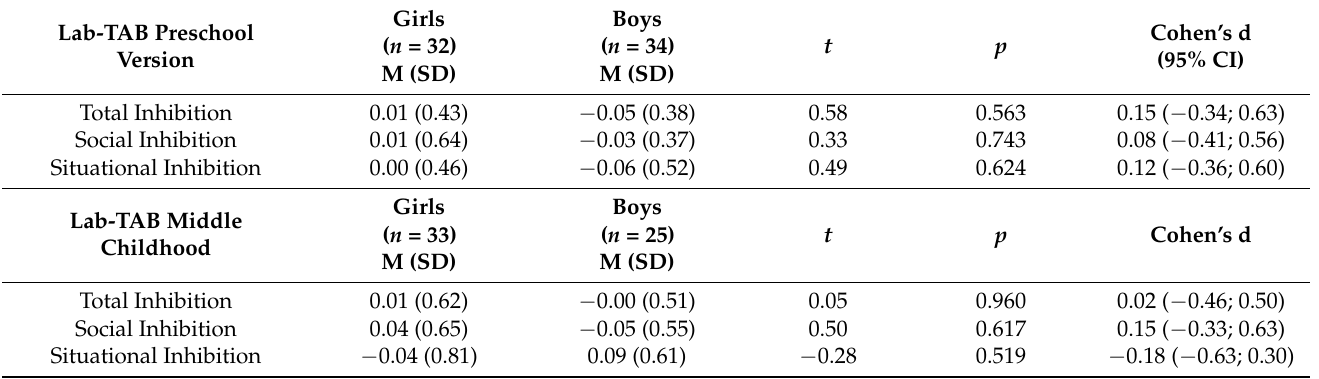
Table 3. Gender effect on Lab-TAB BI scores ( t -test, effect sizes, and 95% confidence